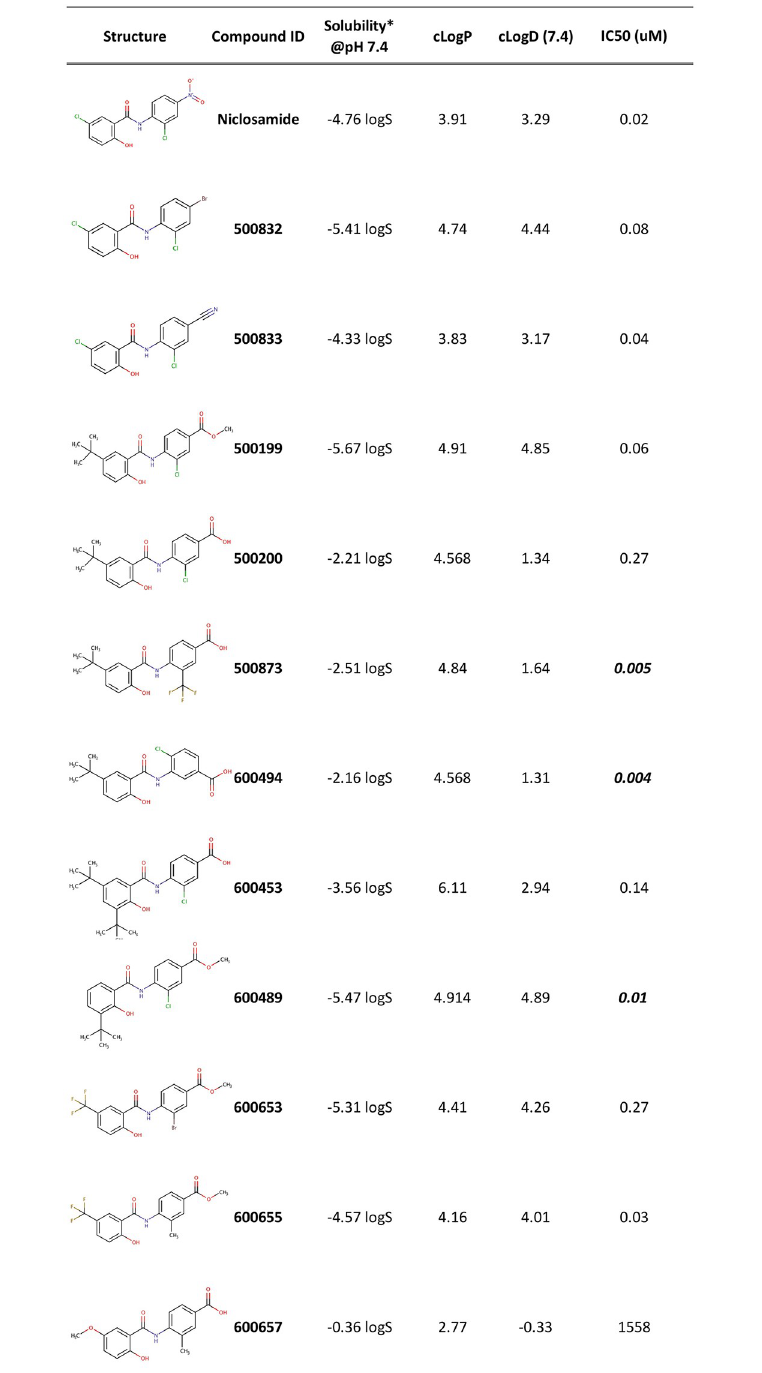
Fig 2. Structure and activity of N-substituted phenylbenzamides in DNL assay. The predicted aqueous solubility � at pH 7.4, cLogP, and cLogD (pH 7.4) were calculated using Instant Jchem or MarvinSketch. Inhibition of steatotic phenotype was quantified in PH5CH8 liver cells using the DNL assay. Lipid synthesis was stimulated in triplicate, in the presence of compounds in 10-point dose response between 1 μ M and 1.9nM. Cells were fixed, labeled and analyzed by high content image analysis. Partial least squares (PLS) regression analysis was used to determine % effect relative to DMSO controls. IC 50 values were calculated for each